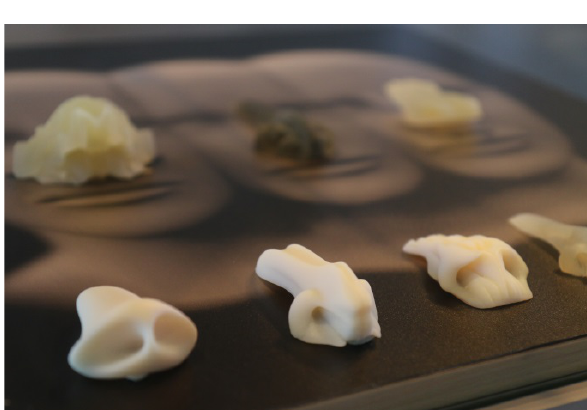
Figure 10 | Marta Flisykowska, Who Nose?, Museo del Traje, Madrid.